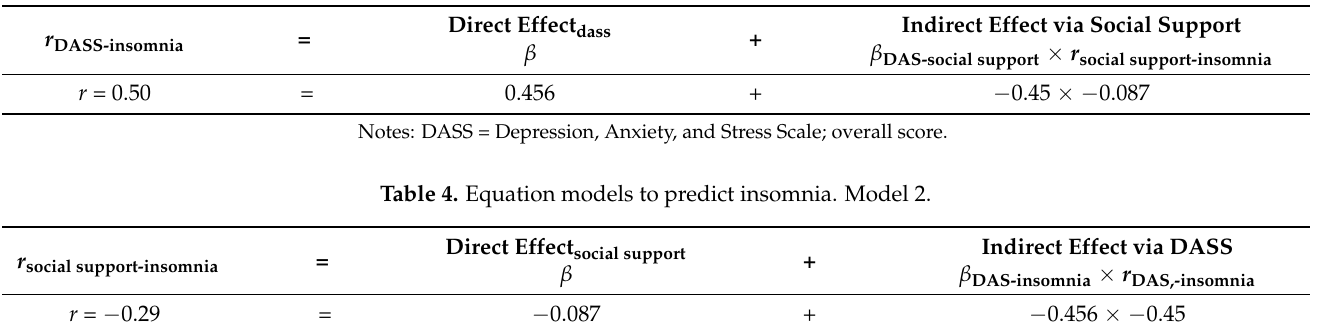
Table 3. Equation models to predict insomnia. Model 1.